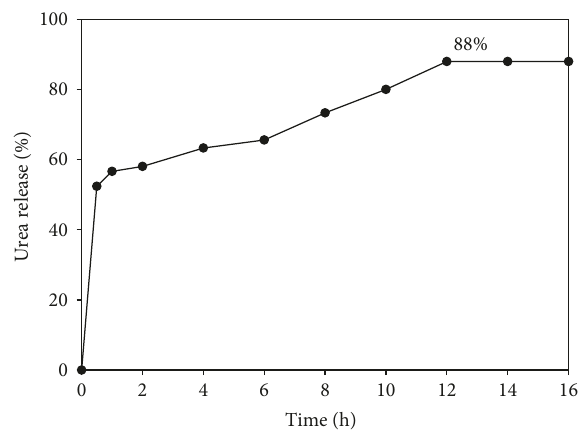
Figure 9: Urea release from wheat-gluten proteins soluble in ethanol (WGPSE) microparticles at 25 ° C and pH